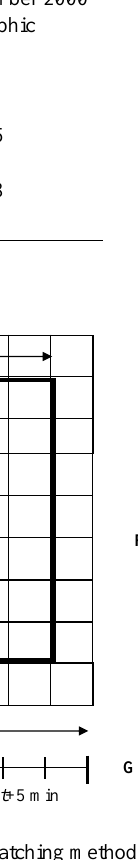
Fig. 4. The window probability matching method Figure 4.